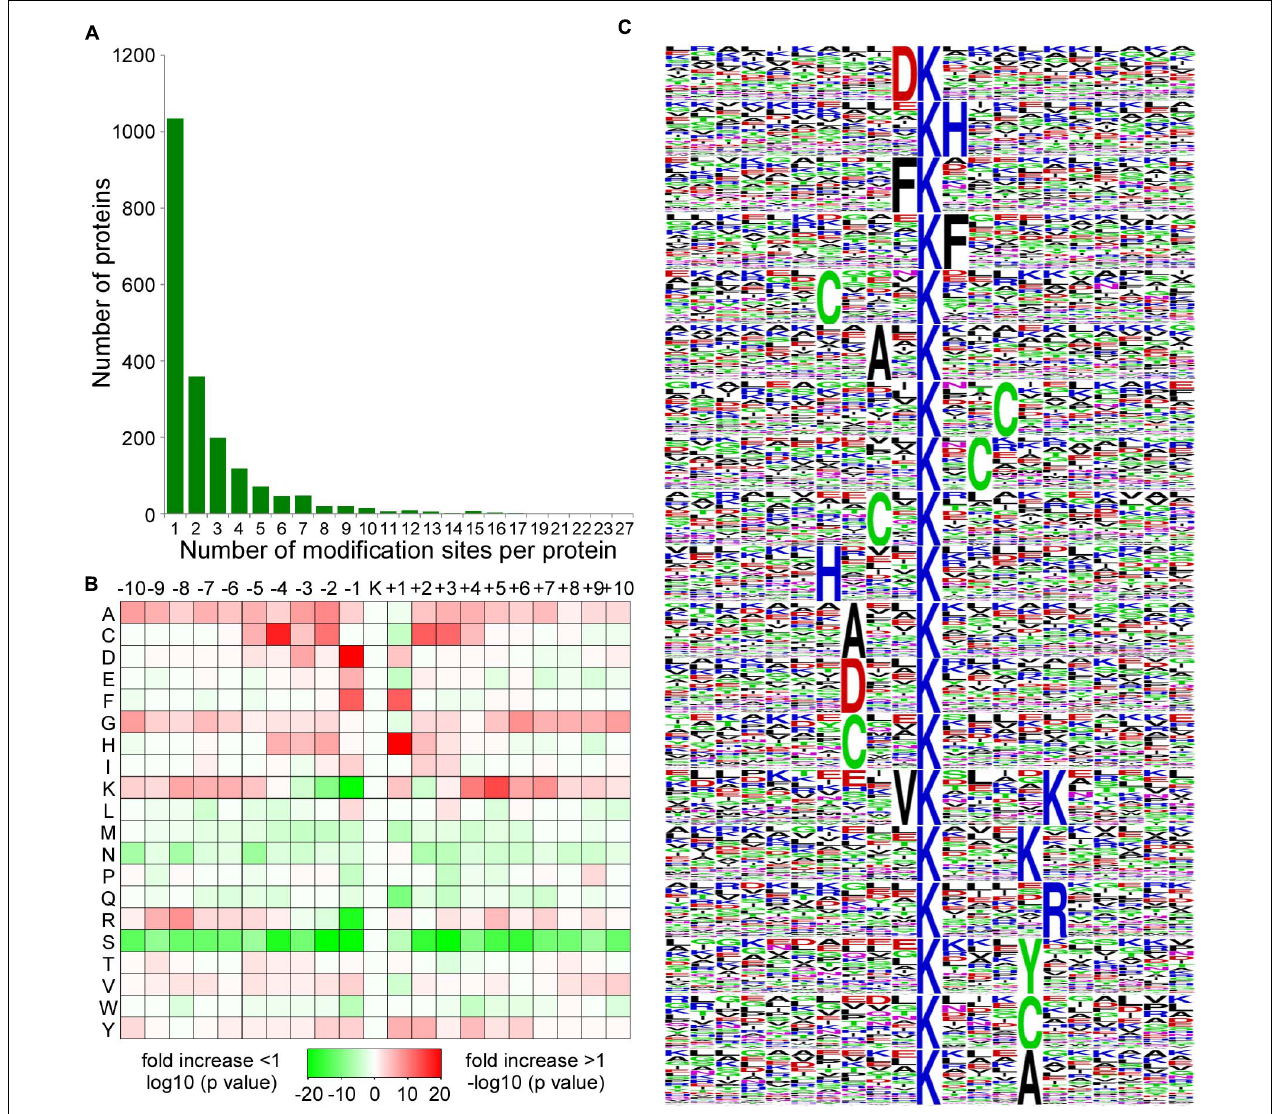
FIGURE 3 | Distribution and enrichment analysis of lysine acetylation sites. (A) The number of acetylation sites on acetylated proteins. (B) Enrichments of amino acids around the acetylation sites. The intensity map shows the relative abundance for 10 amino acids from the lysine-acetylated site. The colors in the intensity map represent the log10 of the ratio of frequencies within acetyl-21-mers vs. non-acetylated (red shows enrichment, green shows depletion). (C) Sequence probability logos of significantly enriched acetylation site motifs for ± 10 amino acids around the lysine acetylation sites. The size of each letter corresponds to the frequency of that amino acid residue in that